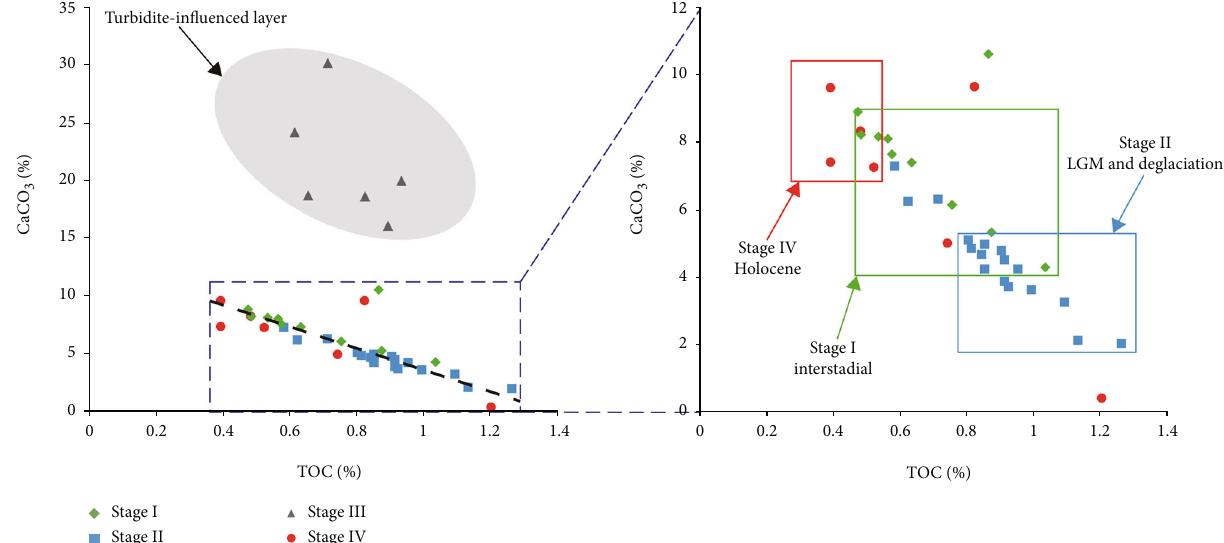
Figure 8: Correlation plots for TOC vs. CaCO past 42